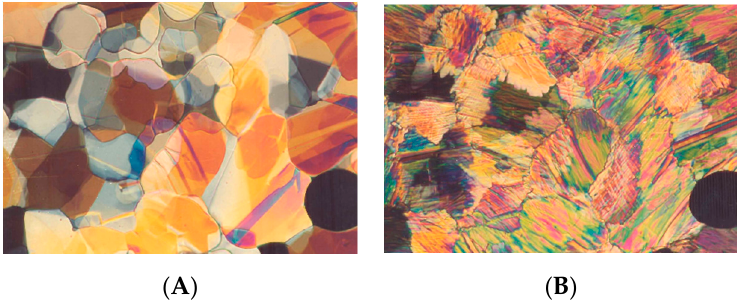
Figure 1. Optical polarizing micrographs displayed by monomer 9M upon cooling from isotropic phase. ( A ) The smectic G mosaic platelets texture obtained at 115.6 °C (320×). ( B ) The smectic H zig-zag line texture obtained at 82.6 °C (320×).